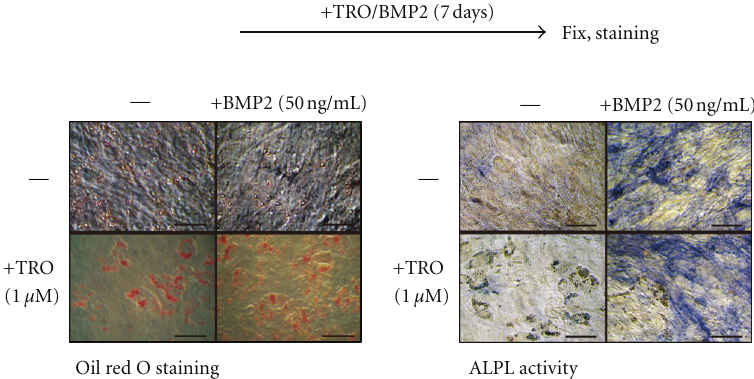
Figure 1: The e ff ect of BMP2 and TRO on adipocyte and osteoblast di ff erentiation of ST2 cells. The scheme of experiments are shown in upper panel. ST2 cells were cultured with one μ M troglitazone (TRO) or 50ng/mL human recombinant BMP2 for seven days. The cells were fixed with 4% formaldehyde/PBS for five min at room temperature, and stained with Oil red O or for alkaline phosphatase (ALPL) activity. Scale bar means 50 μ